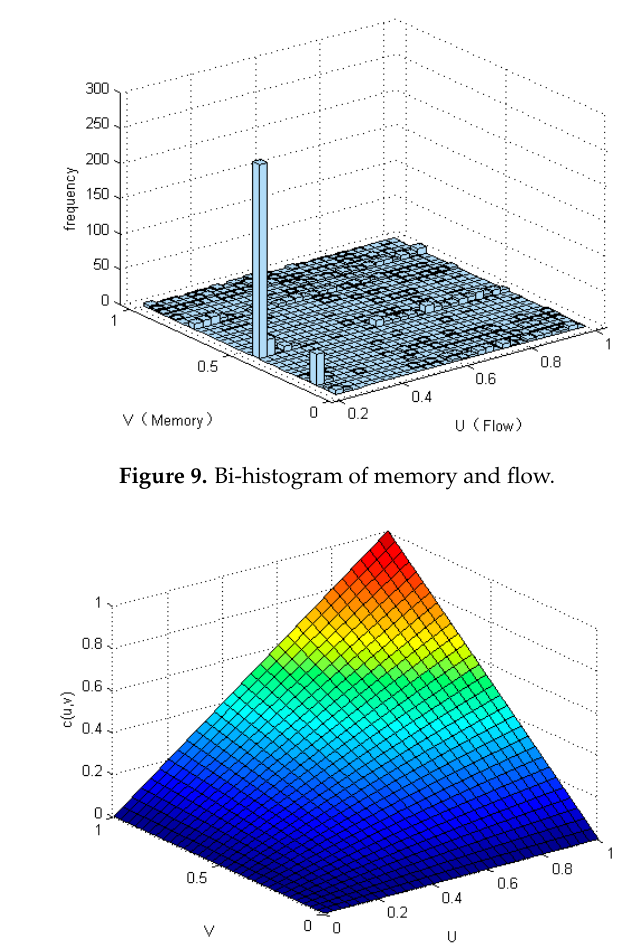
Sensors 2017 , 17 , 553